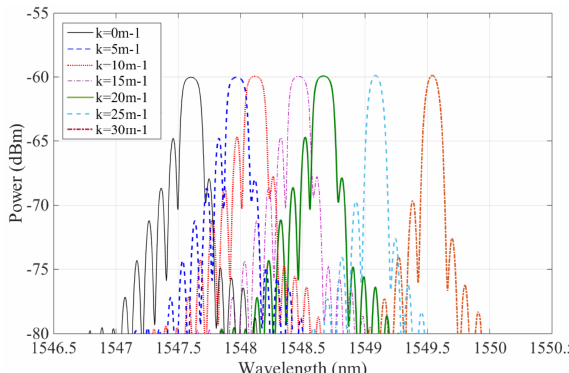
Figure 9. Wavelength shift and intensity of FBG sensor in a soft actuator.